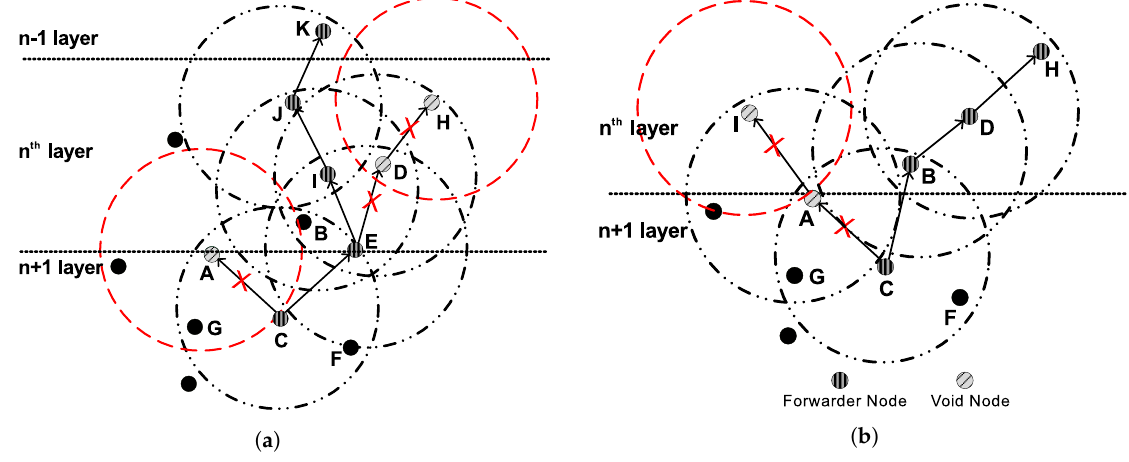
Figure 6. Forwarder Node Selection in FLMPC-Two. ( a ) Cross Node PFN; ( b ) Relay Node